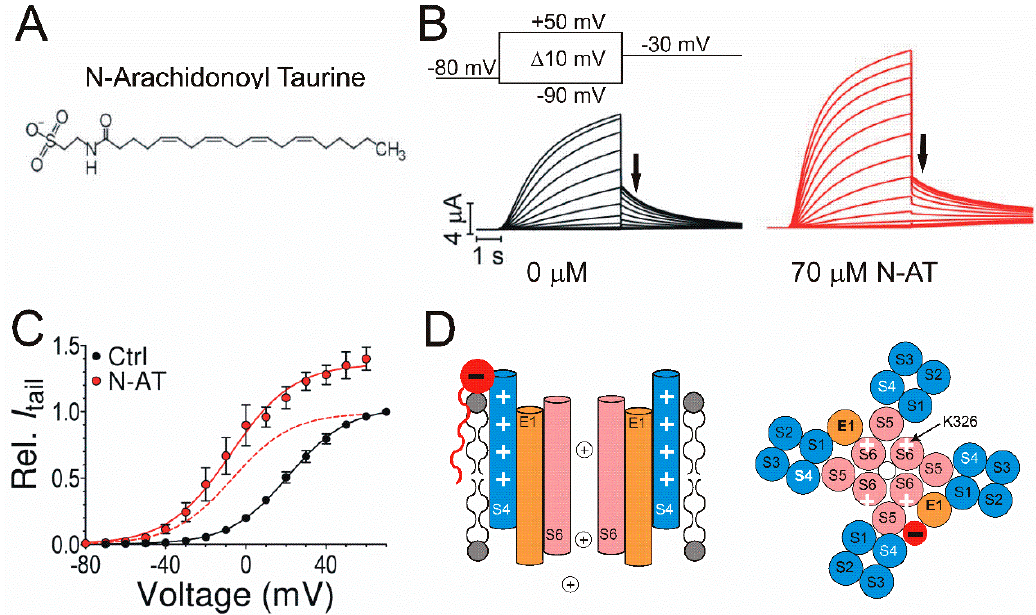
Figure 4. Effects of N-arachidonoyl taurine (N-AT) on cardiac KCNQ1/KCNE1 channels. ( A ) Structure of the polyunsaturated fatty acid (PUFA) analog N-AT with a negatively charged head group and a hydrophobic tail group. ( B ) Representative current traces from KCNQ1/KCNE1 channels in 0 μ M N-AT (black) and 70 μ M N-AT (red) in response to the indicated voltage protocol. Cells are held at − 80 mV and stepped to voltages between − 90 and +50 mV in +10 mV followed by a step to − 30 mV. Arrows indicate the tail currents. ( C ) Voltage dependence of currents from KCNQ1/KCNE1 channels in 0 μ M N-AT (black) and 70 μ M N-AT (red) indicating an increased maximum conductance and negative shift of voltage dependence. Normalized voltage dependence of KCNQ1/KCNE1 channels in 70 μ M N-AT is indicated as a red dashed line. ( D ) Illustration of the lipoelectric mechanism. Schematic side view (left) of KCNQ1/KCNE1 channels with S4 (blue), S6 (pink) and KCNE1 (orange). Electrostatic interaction between the negatively charged PUFA head group (red) and positive charges (white plus symbol) in S4. Schematic top view (right) of a tetrameric KCNQ1 channel with only two KCNE1 subunits. Electrostatic interaction between the negatively charged PUFA head group (red) and positively charged K326 (white plus symbol).